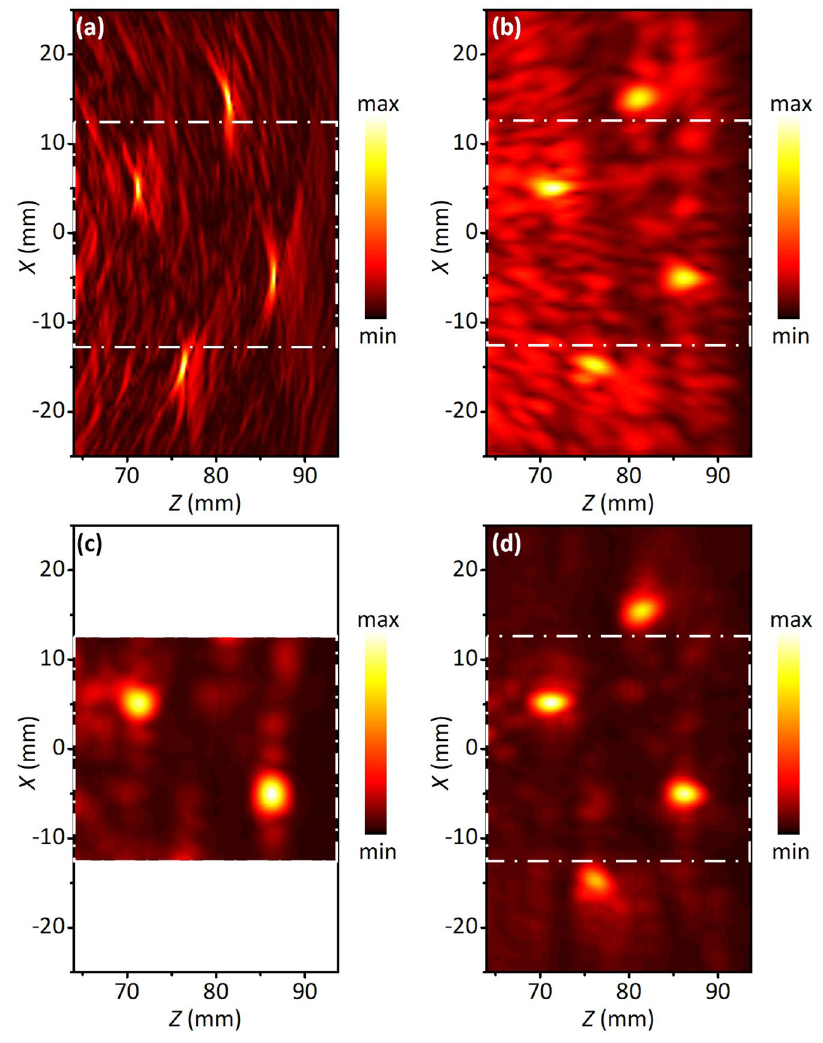
Figure 4. Reconstructed images of the ROI behind an acoustically scattering layer. ( a ) Image reconstructed by the delay-and-sum (DAS) beamforming method. ( b ) Image reconstructed by the time reversal operator without filtering. ( c ) Image reconstructed by the FTR method. ( d ) The final image after applying the CFMF method. The CFMF method significantly reduce the background noise ( d ), in comparison with the other methods ( a – c